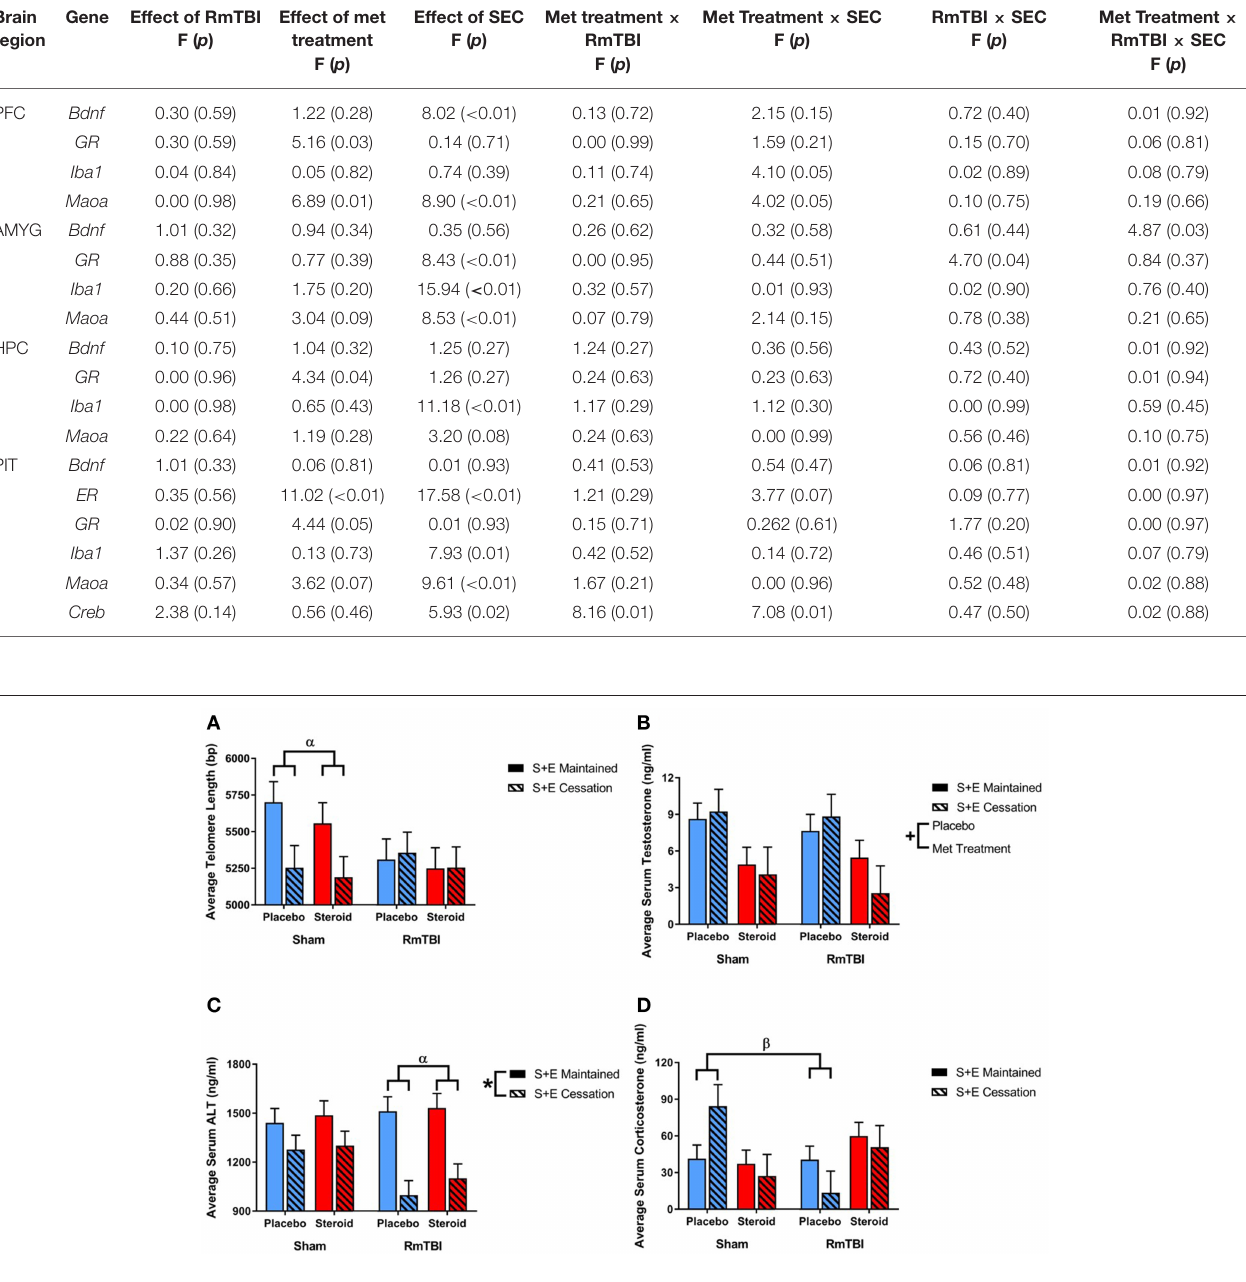
FIGURE 6 | Bar graphs displaying the results from telomere length analysis and serum ELISA results. Means ± standard error are displayed where *main effect for SEC, + main effect of Met treatment, α significant RmTBI by SEC interaction, and β significant Met treatment by RmTBI interaction p ≤ 0.05. (A) Displays average telomere length for each of the groups at time of sacrifice. Post-hoc analysis demonstrated that the Injury by SEC interaction was driven by the sham animals, whereby telomere length was significantly reduced in response to cessation of AAS and exercise if the rat did not receive repetitive injuries, but was not reduced in animals that experienced cessation of AAS and exercise, and RmTBI, p = 0.02. (B) Displays the mean serum levels of testosterone at time of sacrifice. (C) Displays mean serum levels of ALT at time of sacrifice. Post-hoc analysis demonstrated that the Injury by SEC interaction was driven by animals in the RmTBI group, whereby those that experienced cessation of AAS and exercise exhibited significant decreases in ALT levels as compared to animals with RmTBI that maintained treatment throughout the experiment, p < 0.01. (D) Displays mean serum levels of corticosterone at time of sacrifice. Post-hoc analysis showed that the Met Treatment by Injury interaction was driven by the placebo group, where sham animals demonstrated elevated corticosterone and animals in the placebo group that received RmTBIs exhibited reductions in corticosterone, p = 0.02. RmTBI, repetitive mild traumatic brain injury; S + E, steroid and exercise; ELISA, enzyme-linked immunosorbent assay; ALT, alanine